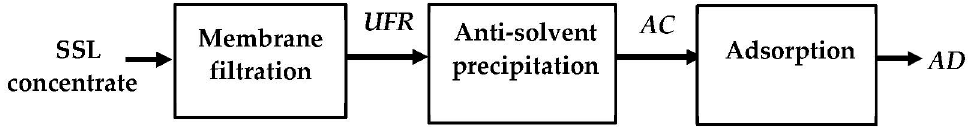
Figure 6. Schematics illustrating the purification scheme for purification of acetylated galactoglucomannan (AcGGM) from SSL concentrate. SSL concentrate is the starting material generated after the SSL was concentrated onsite at the softwood biorefinery using an ultrafiltration device. UFR: ultrafiltration retentate; AC: antisolvent-precipitation concentrate; AD: adsorption preparation.